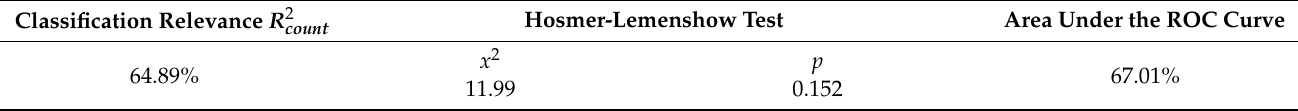
Table 6. The degree of fit of the logistic model to empirical